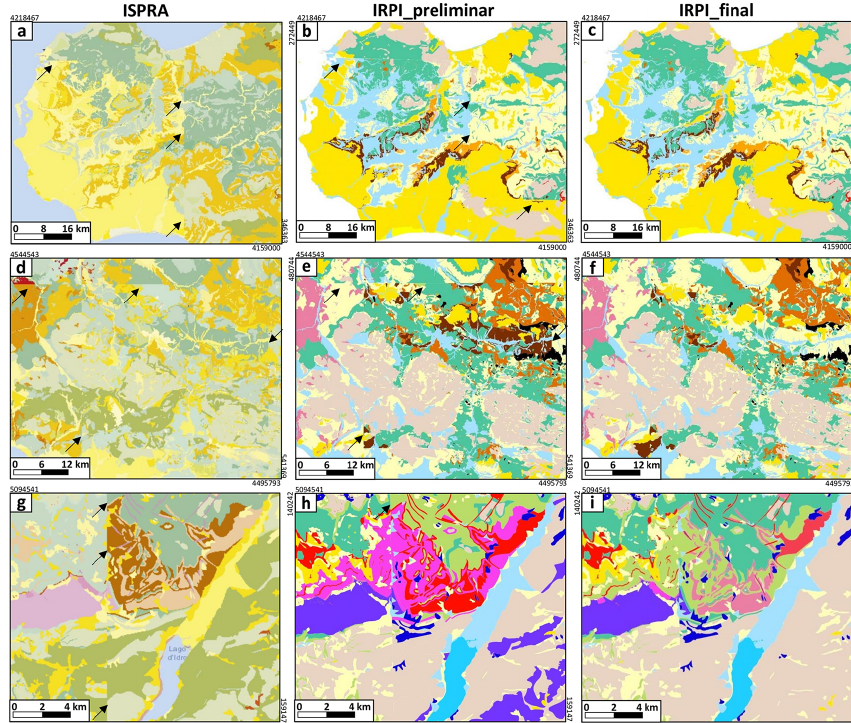
Figure 7. Comparison of two different classifications of the same source dataset for selected areas of the Sicily (a, b, c) , Campania (d, e, f) , and Lombardy (g, h, i) regions. Examples from the lithological map of Italy according to the ISPRA classification as visualized in vector form at the ISPRA website (Table 1, ID 5) are shown in panels (a) , (d) , and (g) . For the same areas, the lithological map of Italy according to our own preliminary semi-automatic classification partially resolved the major inconsistencies along the boundaries of the geological sheets already present in panels (a) , (d) , and (g) , even if critical boundaries still remain; see the black arrows as a reference. Most of the inconsistencies were resolved manually by expert analysis in the final version of our map (c, f, i) , leading to a substantial improvement of the lithological harmonization along the borders of the original geological